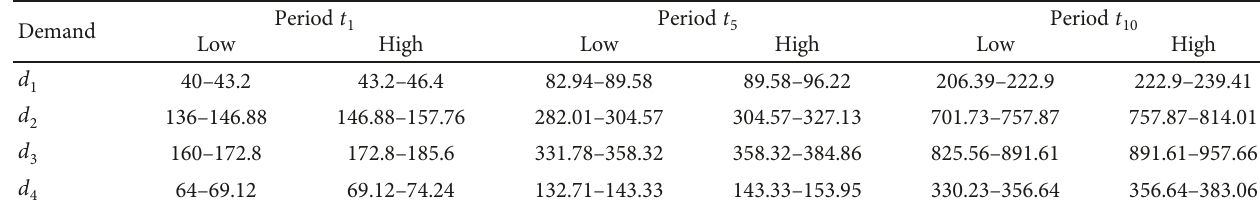
Table 15: Maximum and minimum demand by bus MWh/ h .